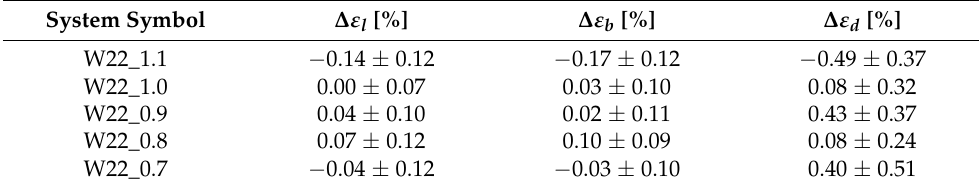
Table 6. The dimensional stability of the bio-foams, measured at 70 ◦ C after 24 h.